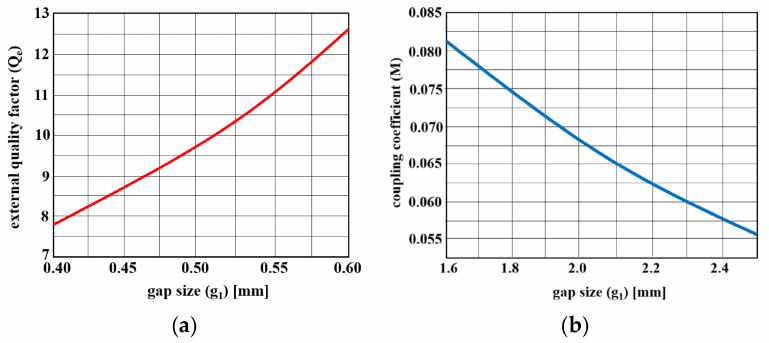
Figure 2. Determination of the gap size according to ( a ) external quality factor and ( b ) coupling coefficient. The variable x is the g − parameter of the low − pass filter prototype [2]. Table 1 shows the gap size analysis for FBW variations. The FBW of 40% corresponds to a gap size of 0.12 mm.